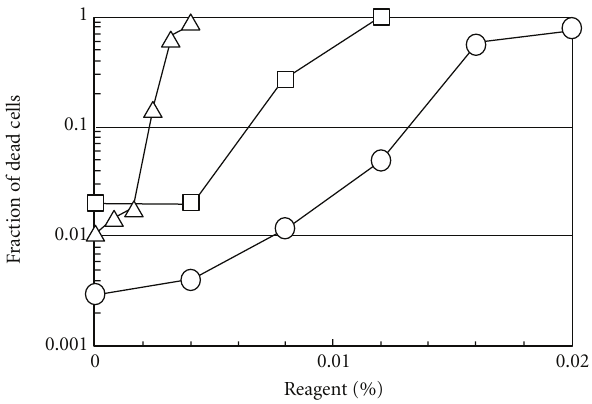
Figure 6: E ff ect of CAE, BKC, and SDS on the cell viability. Confluent monolayers of Vero cells were incubated in 0.85% sodium chloride solution (pH 5.5) containing 20 mM MES and varying concentrations of each compound at room temperature for 15 min. The treated cells were trypsinized to obtain a single cell suspension and the amounts of the live and dead cells in each culture were determined by a dye exclusion test with trypan blue. Circles ( (cid:4) ) for CAE; triangles ( (cid:5) ) for BKC; squares ( (cid:2) ) for SDS. PV-1 (triangle), when the virus-infected cells were incubated in the medium containing varying concentration of CAE (open symbol) or BKC (closed symbol): note that the highest concentrations used are still below the concentrations used for virus inactivation. The multiplication of these two viruses was much more strongly suppressed by BKC than CAE.